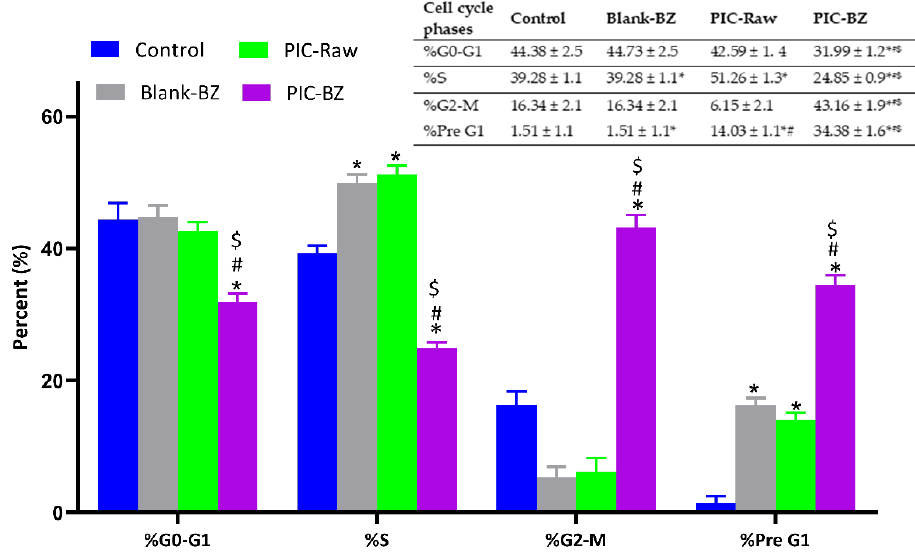
Figure 7. Impact of Blank-BZ, PIC-raw, or PIC-BZ treatments on A549 cell cycle phases with data table (inset). Data are the mean of 4 independent experiments ± SD. * Significantly different from control, p < 0.05; # significantly different from Blank-BZ, p < 0.05; $ significantly different from PIC-raw, p < 0.05.